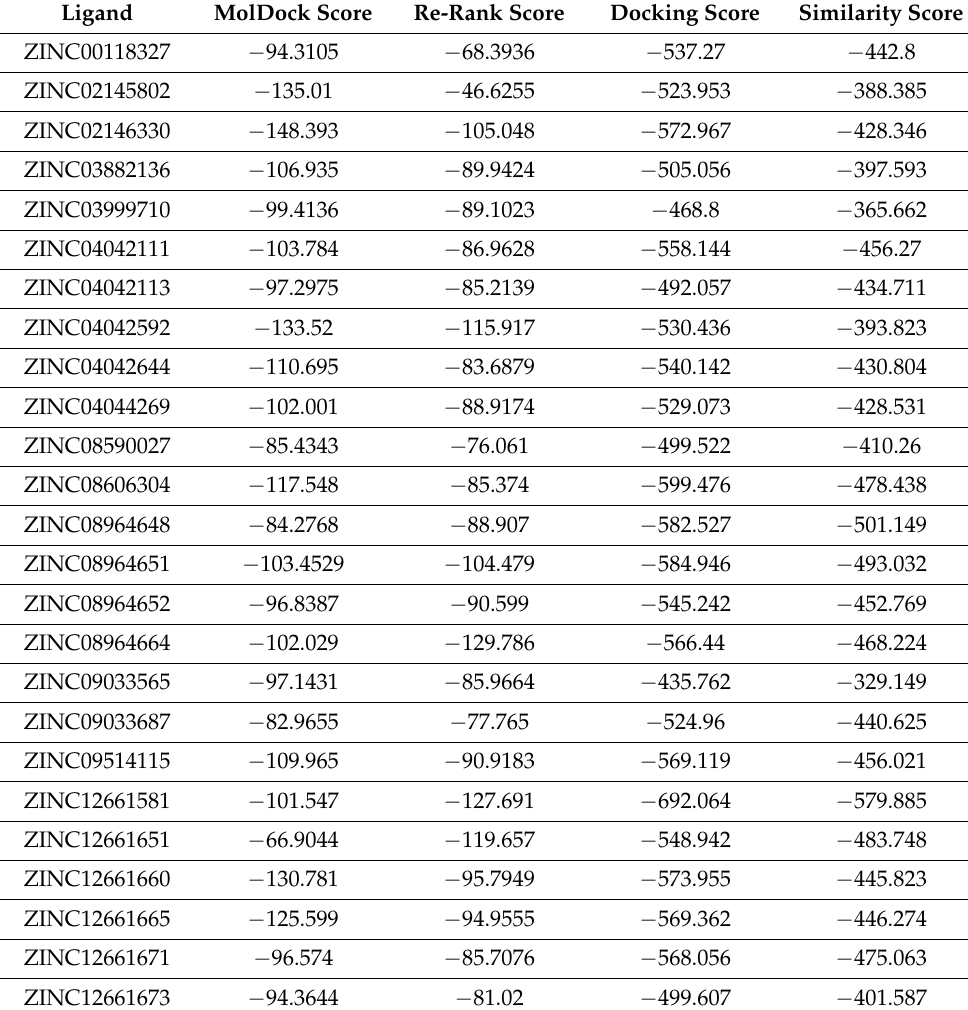
Table 4. The binding scores of identified leads from